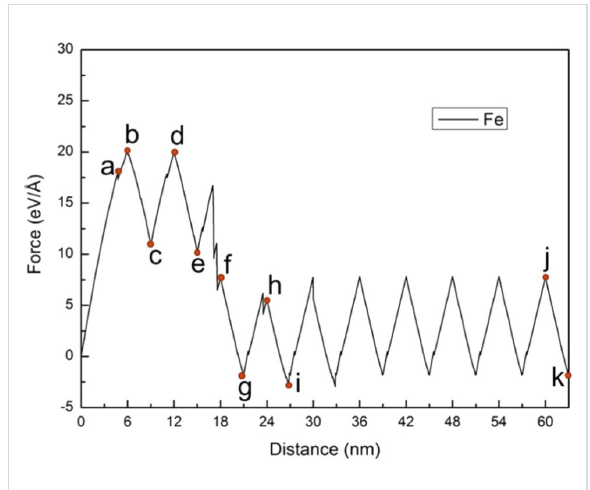
Figure 15: Force–distance curve of Fe under ten times of cyclic loading, where the first shear distance of the sample was 6 nm, and the reverse shear and shear distance were 3nm. The letters a–k repre- sent the observation positions in Figure 16.